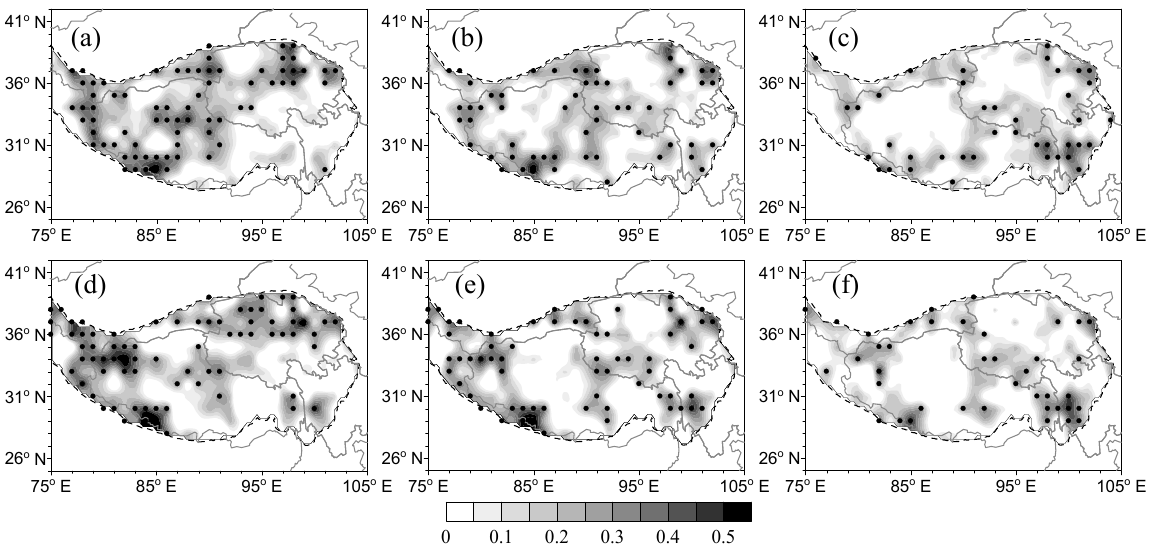
Figure 7. The correlations between spring snowmelt and soil moisture (from left to right: soil moisture levels at depths of 0–7 cm, 7–28 cm and 28–100 cm) in the TP: ( a – c ) the correlations between snowmelt and soil moisture; ( d – f ) the correlations between snow depth and soil moisture. The black spot areas passed the 90% significance test. Dotted line outlines the areas of the TP with an average altitude greater than 3000 m.